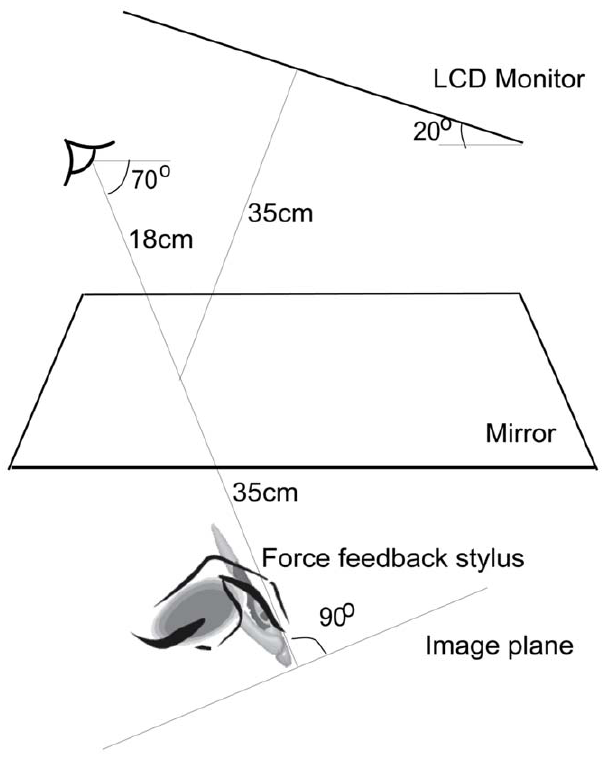
Figure 2. Schematic of the visuo-haptic apparatus. Through a monocular aperture, the observer viewed the sinusoidal corrugations with random-dot textures simulated on an LCD monitor, imaged by a mirror at the same location as force-feedback to the observer’s finger generated by a PHANTOM stylus.